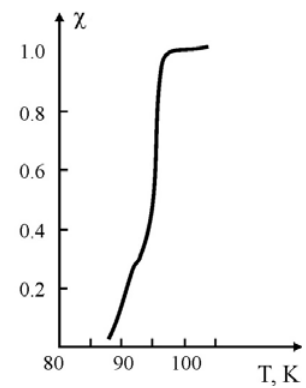
Ba Cu O ceramic at 80 ° C. Ceramic/binder 1 2 3 7-x